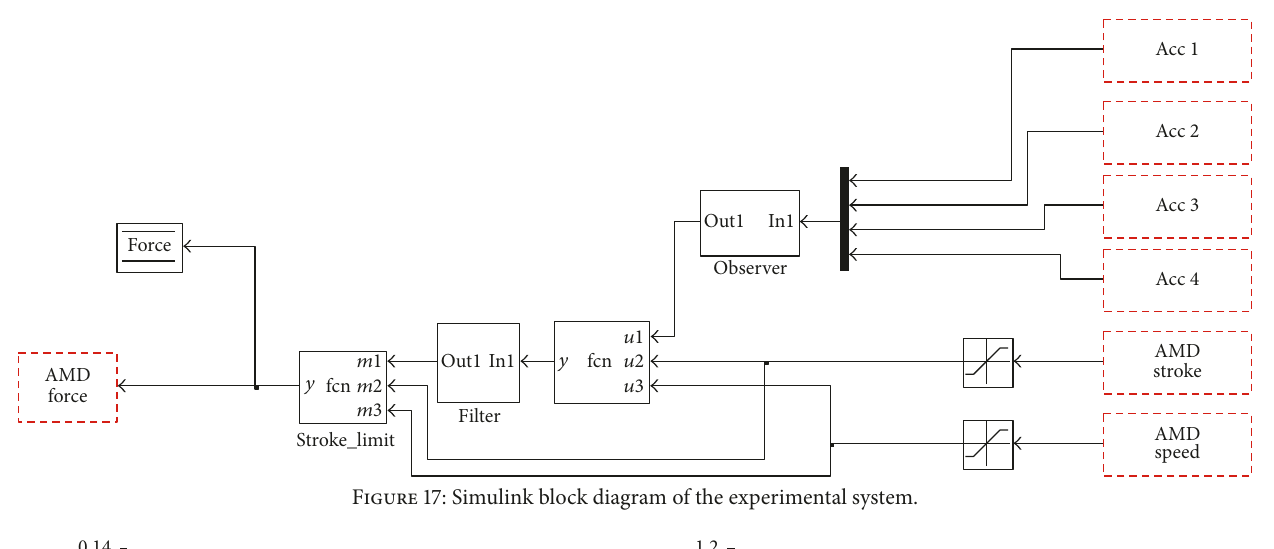
Figure 17: Simulink block diagram of the experimental system.